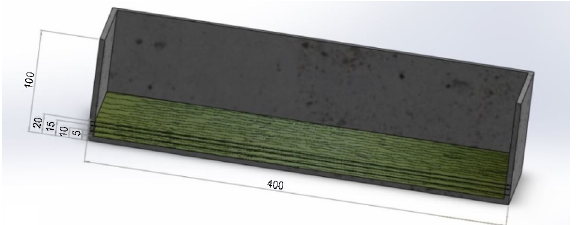
Fig. 5. Group 4 specimens scheme (is shown warps location and fibers orientation in them, in the